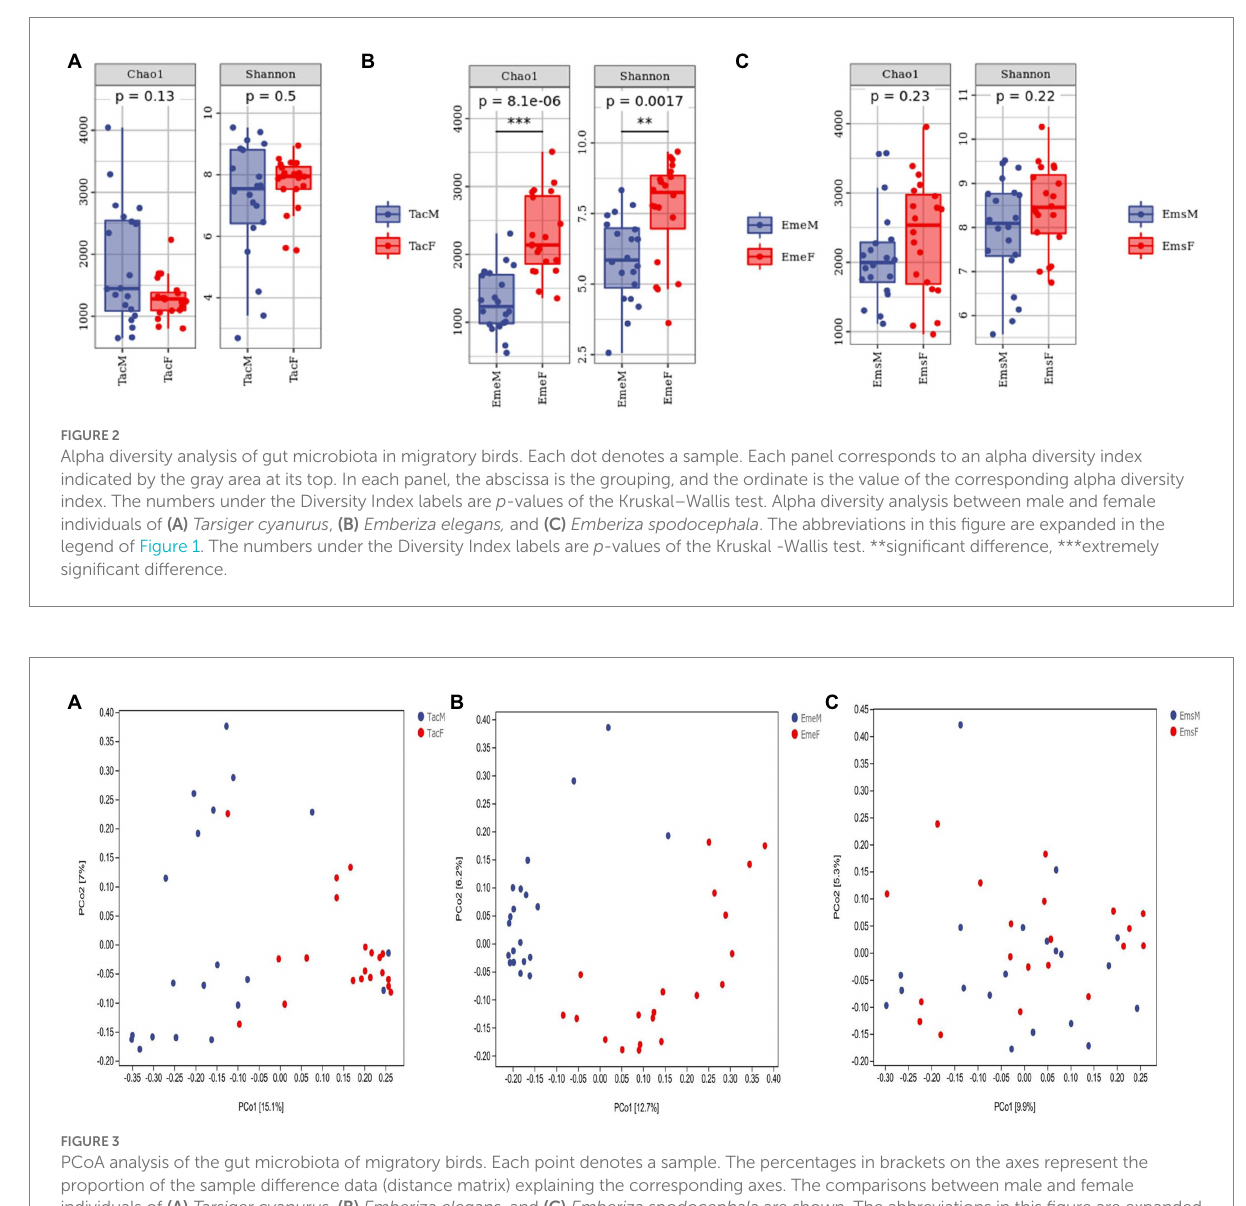
FIGURE 3 PCoA analysis of the gut microbiota of migratory birds. Each point denotes a sample. The percentages in brackets on the axes represent the proportion of the sample difference data (distance matrix) explaining the corresponding axes. The comparisons between male and female individuals of (A) Tarsiger cyanurus , (B) Emberiza elegans , and (C) Emberiza spodocephala are shown. The abbreviations in this figure are expanded in the legend of Figure